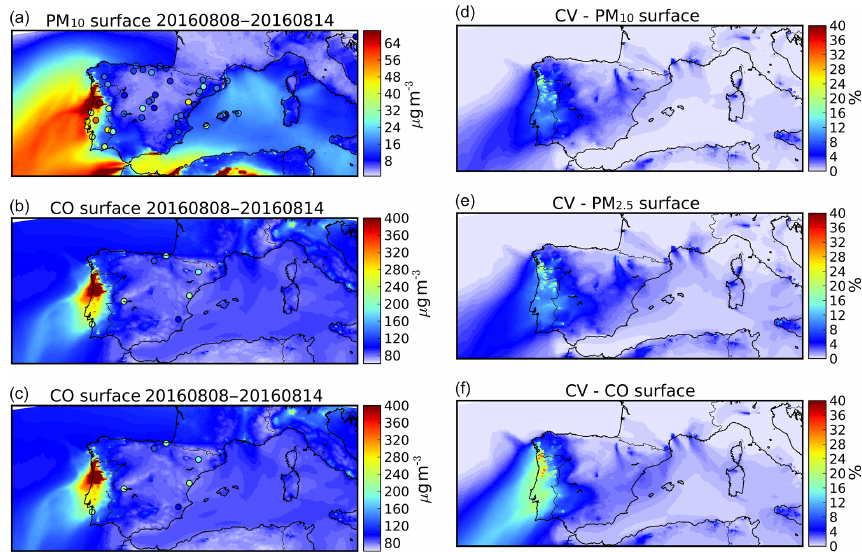
Figure 12. (a–c) Average surface PM 10 , PM 2 . 5 , and CO simulated by CHIMERE (experiment BA-sf-MISR) and observations at surface rural background sites (colored dots) during the time period 8–14 August 2016. (d–e) Coefficient of variation (standard deviation / mean value) of the ensemble of experiments (described in Table 4, excluding BA-sf-SEVIRI-MISR; cf. text for details).